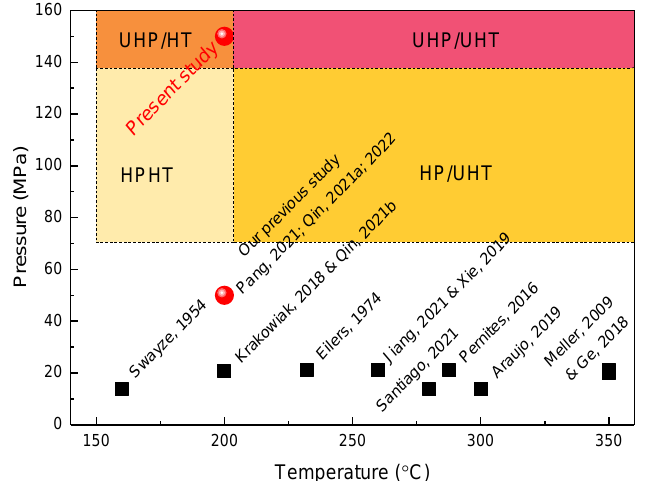
Figure 1. Comparison of curing conditions of previous studies. HPHT conditions in previous study tiers categorized by Baker Oil Tools [4 – 18].